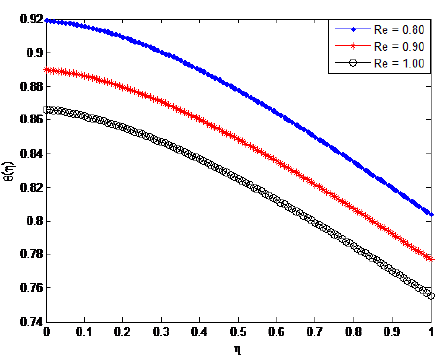
Figure 14. Influence of Reynold’s number on dimensionless Dimensionless temperature